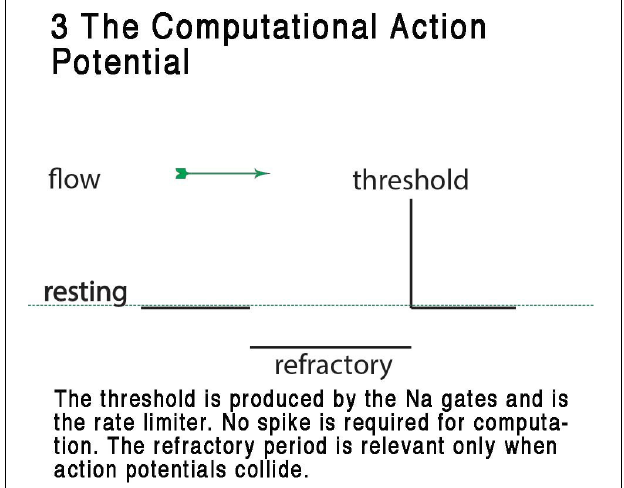
FIGURE 3 | Representation of the CAP, showing the digital resting phase, digital threshold and the analog refractory phase. In this view, the resting potential serves as the ternary 0 of a ternary action potential. Any rise above threshold is the digit or +1 and the refractory period acts as phase -1 refracting any digit+1 during collision to 0. The refractory period is analog and is a result of the specific dynamic of the membrane at that point where the action potential exists. From Johnson and Winlow (2017a) – reproduced under the Creative Commons